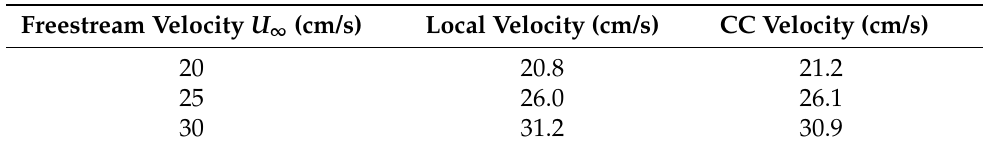
Table 1. Results of the measured convection velocity by cross correlation (CC) of whiskers w1 and w2, situated outside of the influence of the bow wake. Local reference velocity at position w2 is taken from the LES simulations in Figure 3.